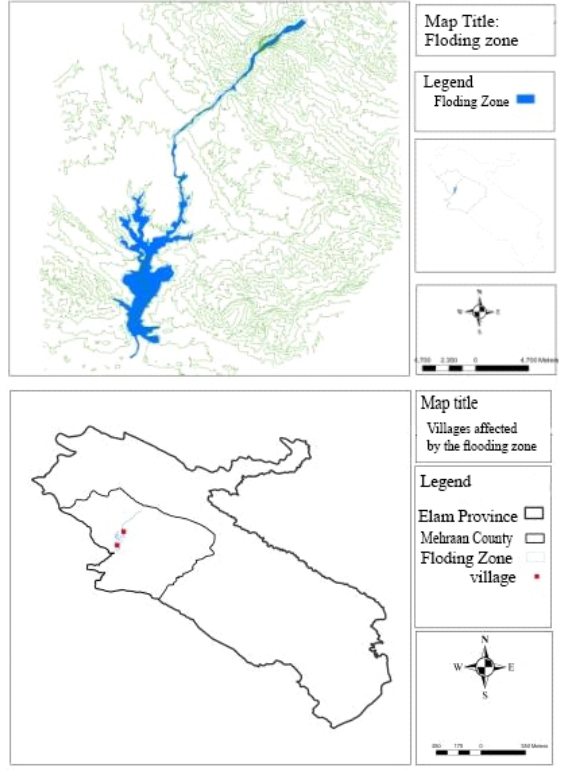
Fig. 4: Villages at risk of flooding